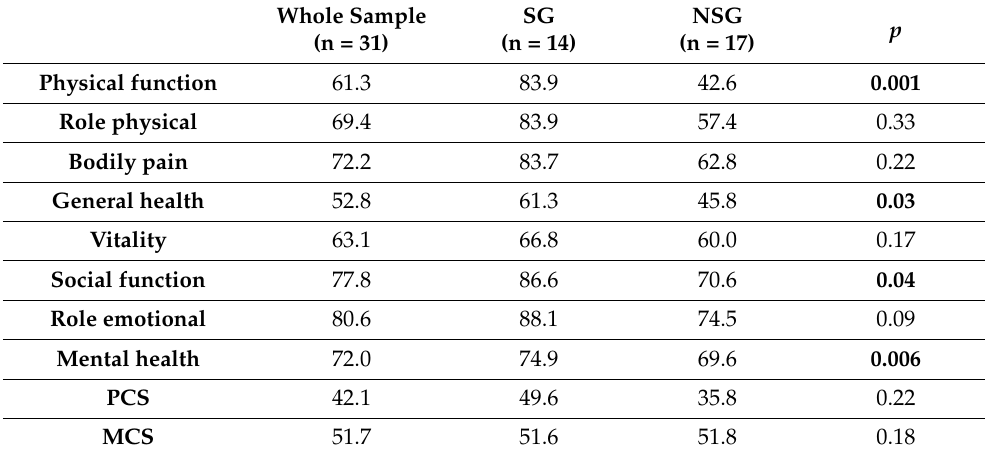
Table 3. Quality of life data of the whole sample and in sport and no-sport group, assessed by